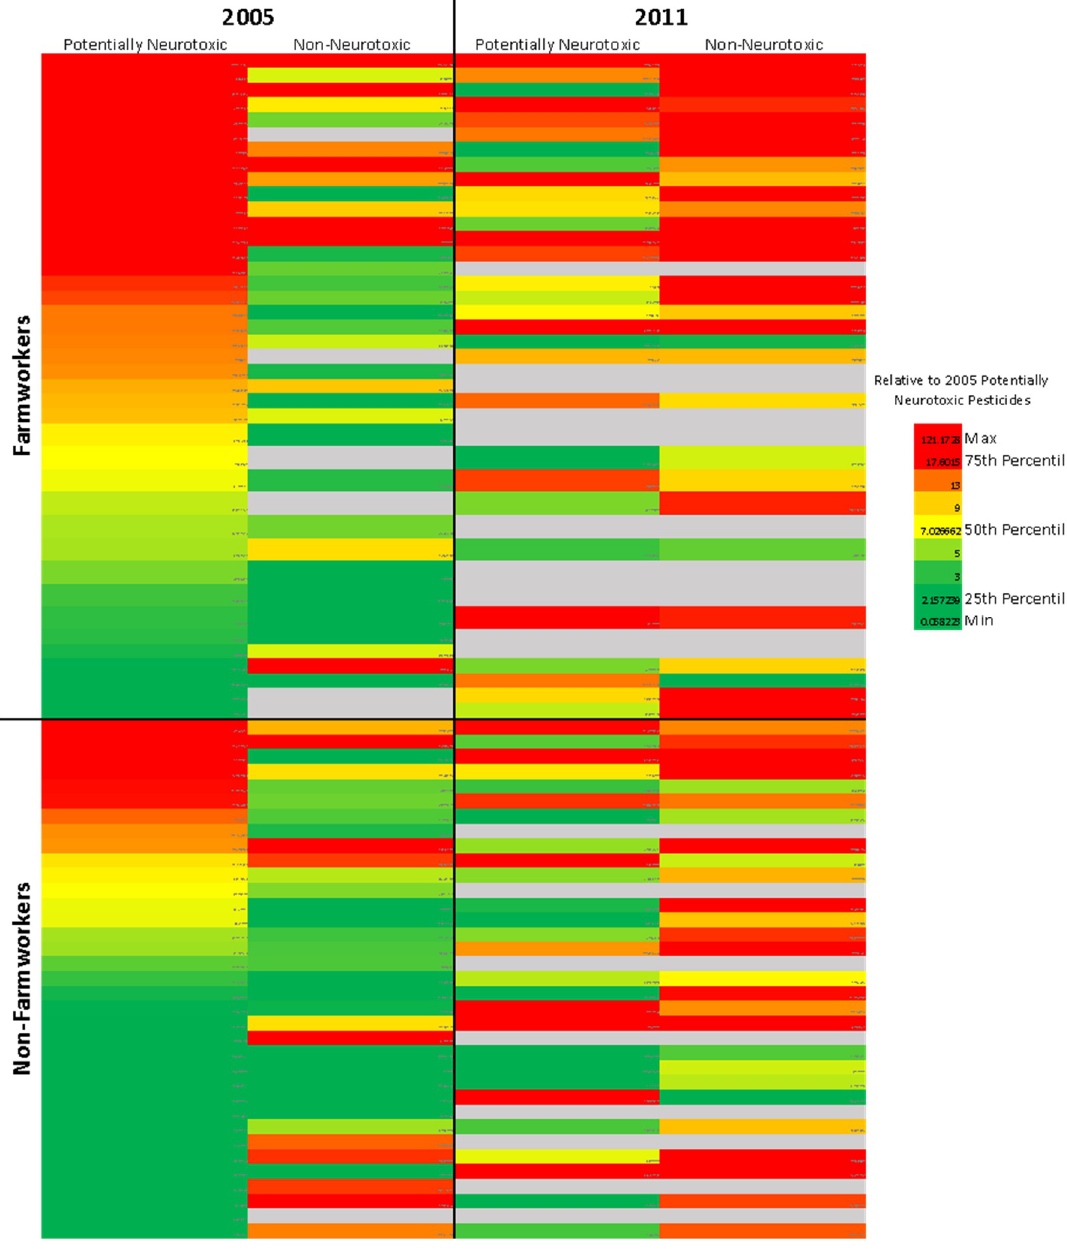
Figure 1. Neurodevelopmental pesticide exposome heat map. Using the pesticide categorizations provided in Tables 1 and 2, the concentrations of potentially neurotoxic and non-neurotoxic pesticides (in µ mol / g dust) were summed for each household (row). Figure 1 shows how the levels of potentially neurotoxic and non-neurotoxic pesticides changed over the two sampling periods (2005 and 2011) and di ff erent between farmworker and non-farmworker households. The red coloring indicates pesticide levels greater than the 75th percentile for potentially neurotoxic pesticides in 2005 (17.6 µ mol / g), yellow indicates the 50th percentile (7.03 µ mol / g), and green indicates the 25th percentile (2.16 µ mol /